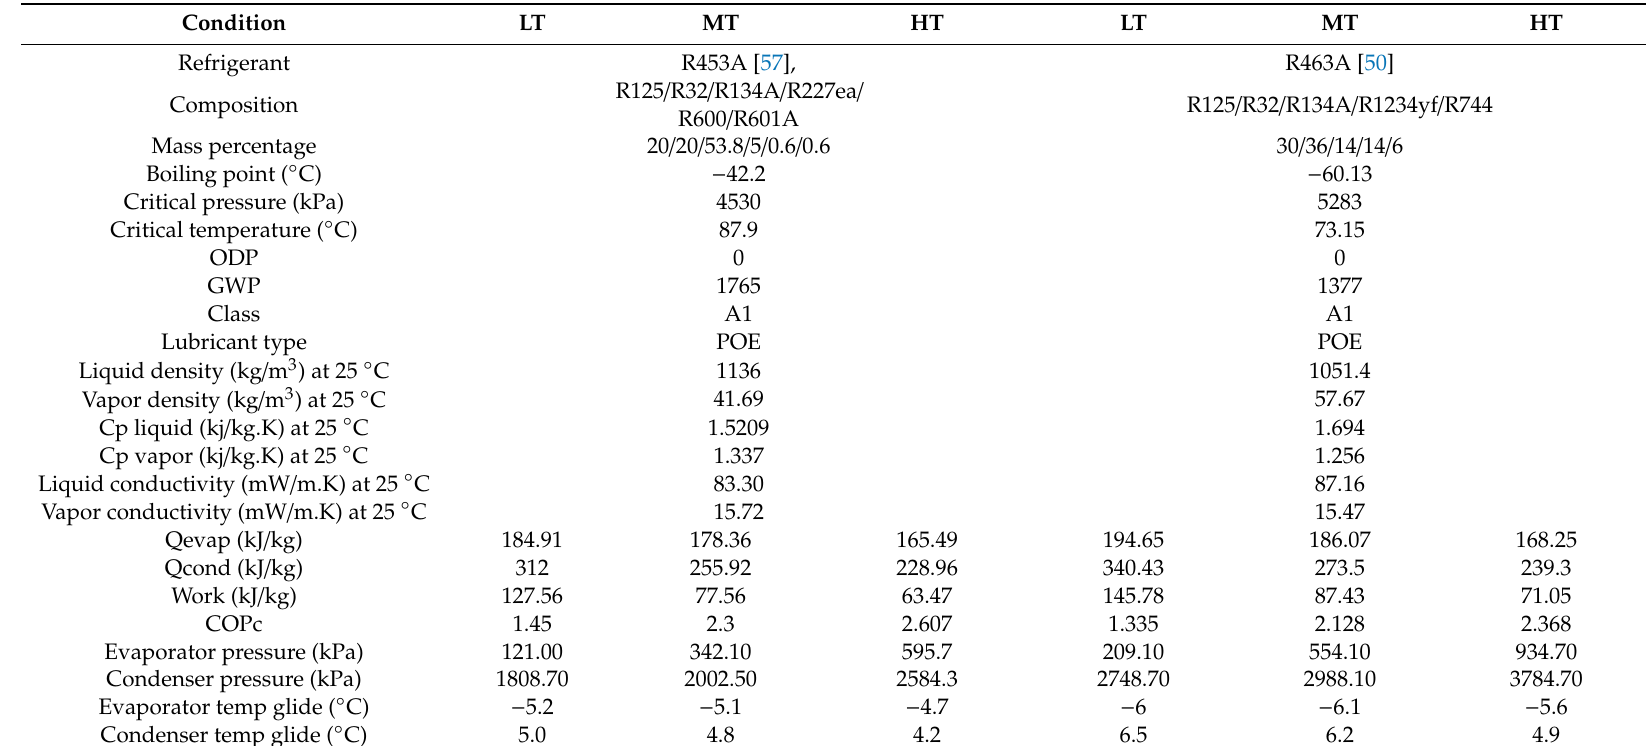
Table 8. Properties of R453A and